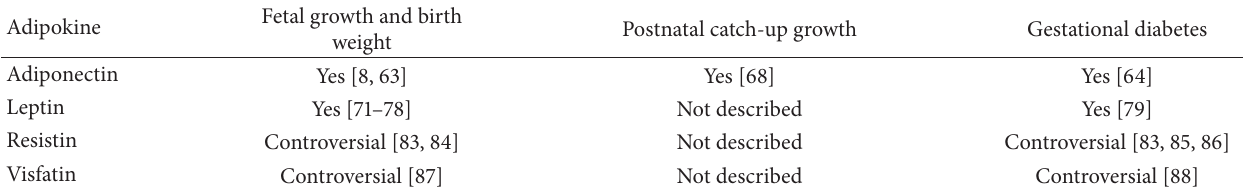
Table 2: Role of adipokines in fetal and postnatal growth and in the onset of gestational metabolic disturbances.